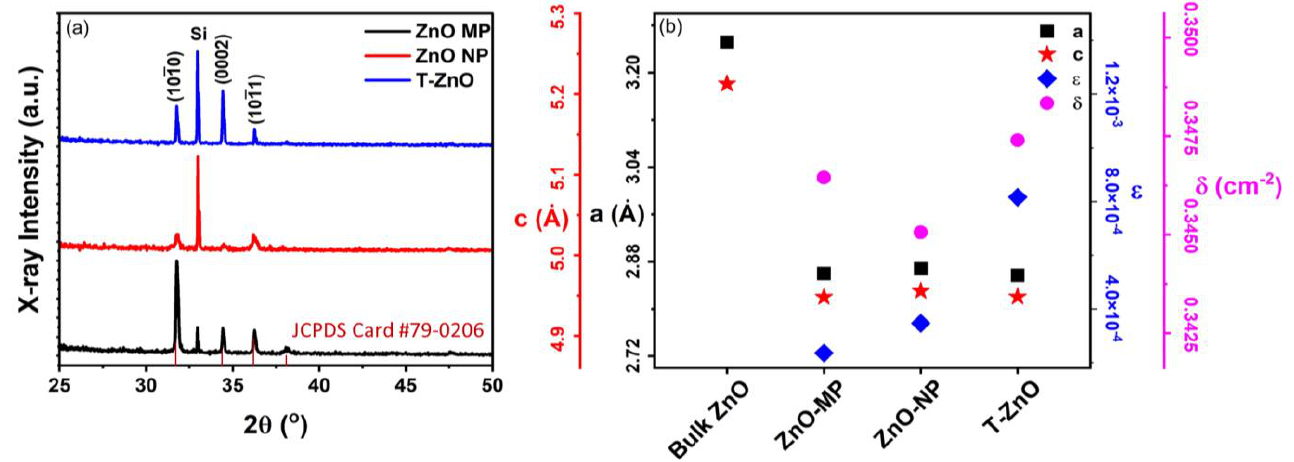
Figure 2. ( a ) XRD patterns of ZnO–MP, ZnO–NP, and T–ZnO thin films. ( b ) The calculated values of interplanar spacing, d, and lattice constant, a, both from peak (002), lattice constant, c, from peak (101), lattice strain, ϵ , and dislocation density, δ . A reference for bulk ZnO XRD intensities (JCPDS Card #79-0206) is also included.